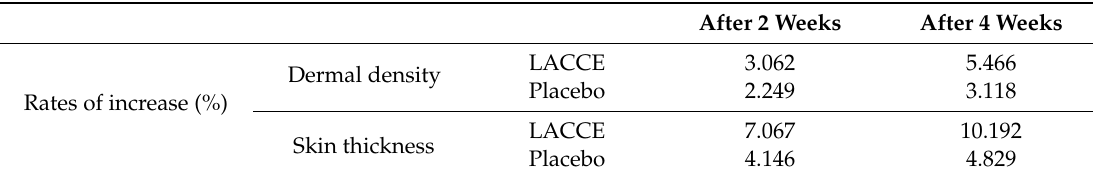
Table 4. Rates of increase in dermal density and skin thickness